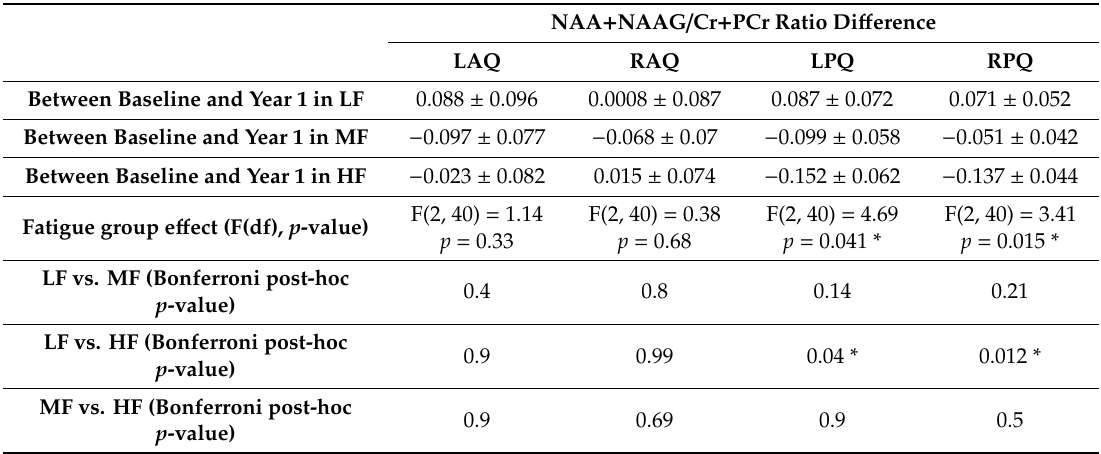
Table 3. One-way ANOVA of the NAA + NAAG / Cr + PCr ratio di ff erence between the fatigue groups.